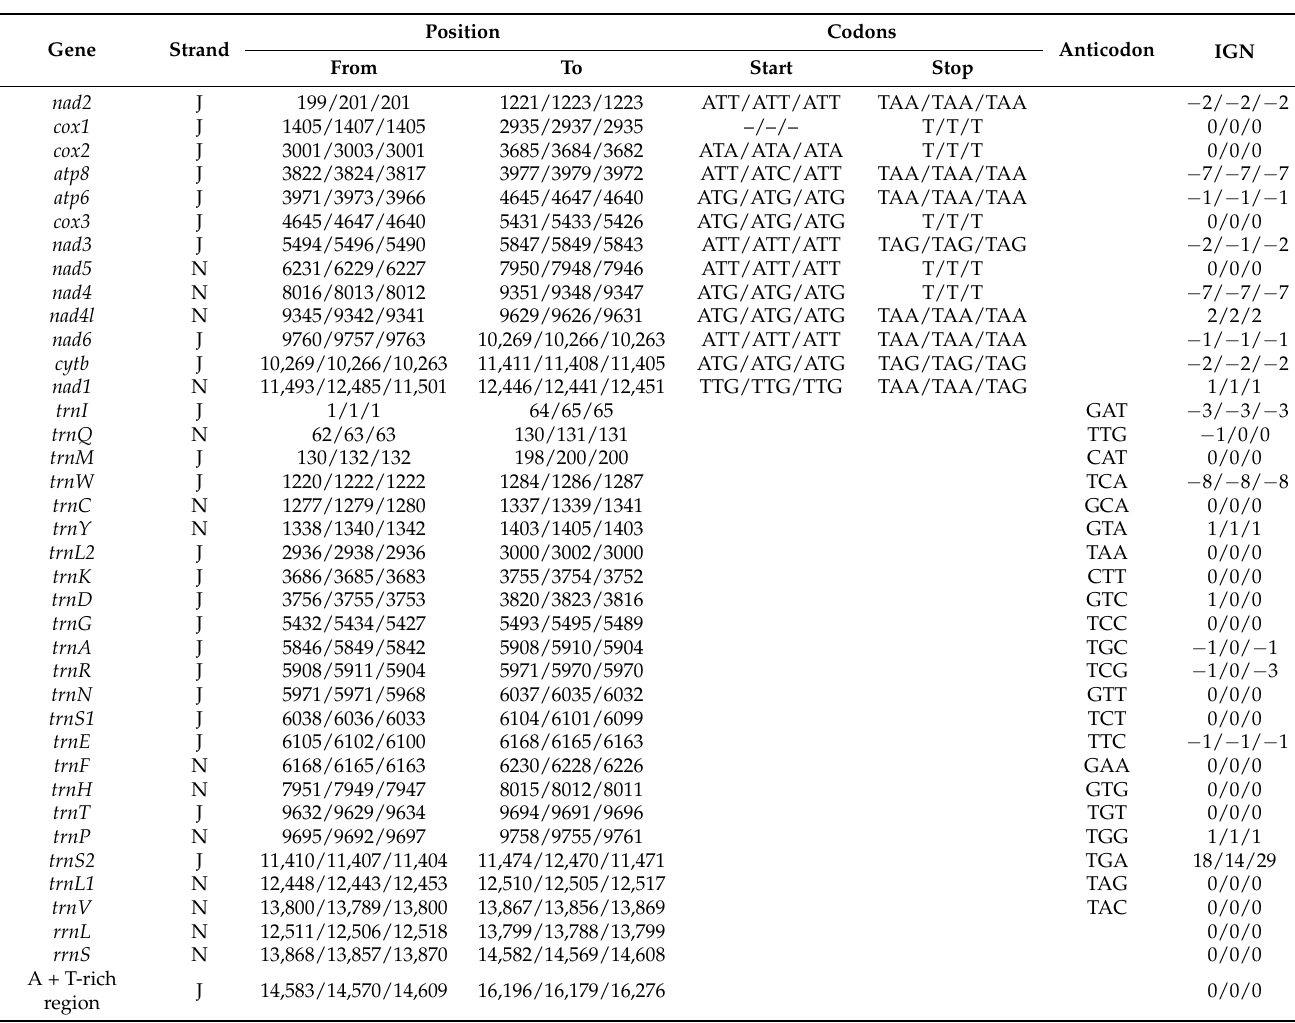
Table 2. The three newly annotated Buprestidae